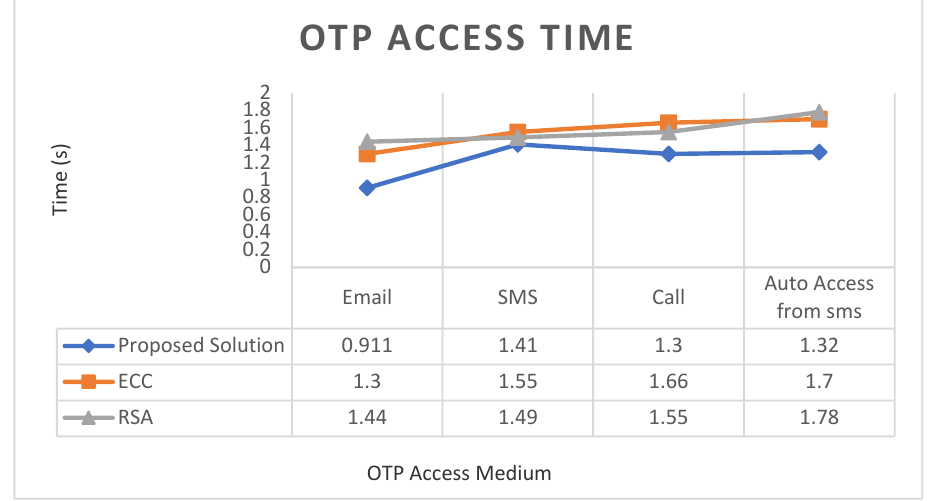
Figure 15. Access time of OTP.